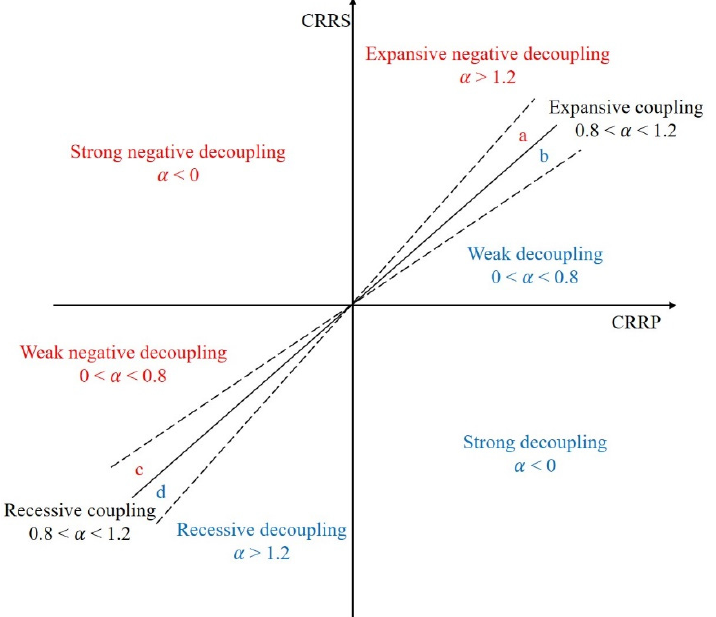
Figure 3. The eight types of rural human–land relationship examined in this study. Notes: CRRS is the change rate of rural settlement area, while CRRP is the change rate of the rural population. Here, a and d indicate the subtypes of expansive coupling and recessive decoupling with 1 < α < 1.2, respectively; correspondingly, the b and c indicate the subtypes of expansive coupling and recessive decoupling with 0.8 < α < 1, respectively. The red font indicates the more extensive use of rural settlements, and the blue font indicates the more intensive use of rural settlements.